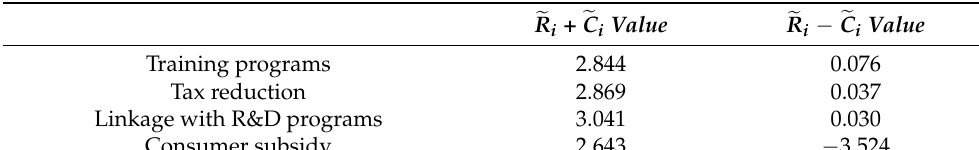
def def value and ( (cid:101) R i − (cid:101) C i ) value of impacts of the three criteria of the Table 8. The sum ( (cid:101) R i + (cid:101) C i )   ( ) def C value + and R C value − of impacts of the three criteria Table 8. The sum i i government policy. of the government policy.